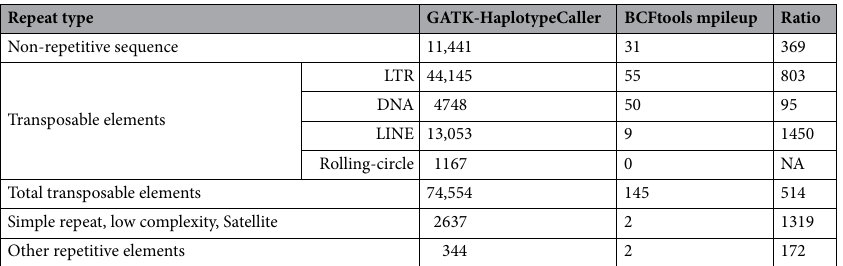
Repeat type GATK-HaplotypeCaller BCFtools mpileup